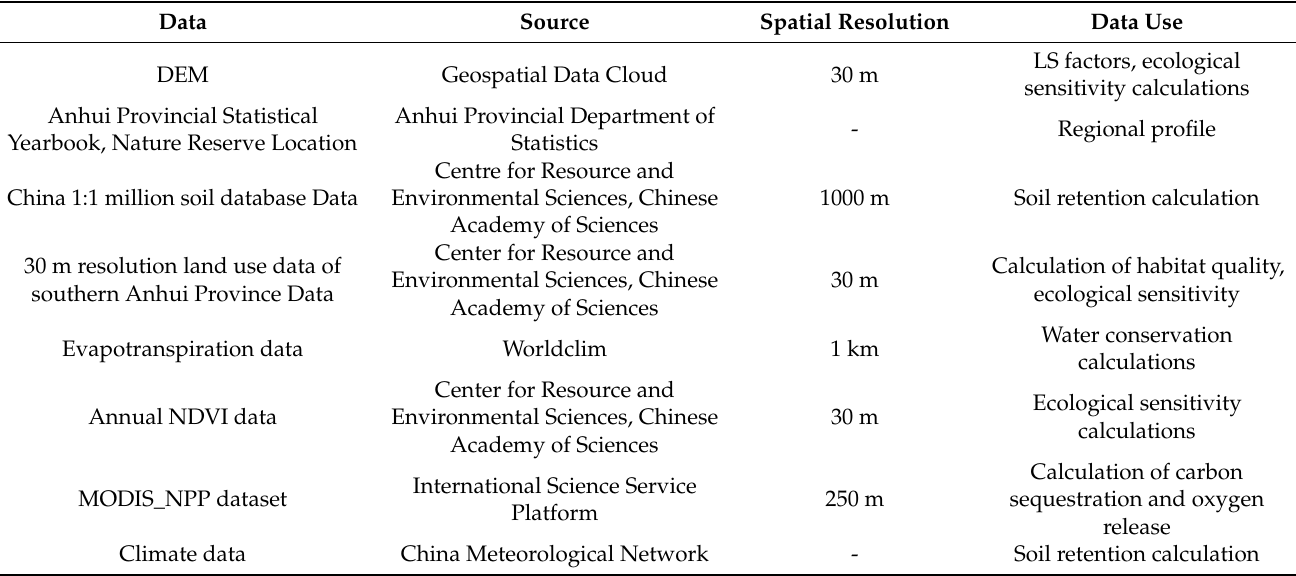
Table 1. Data sources and